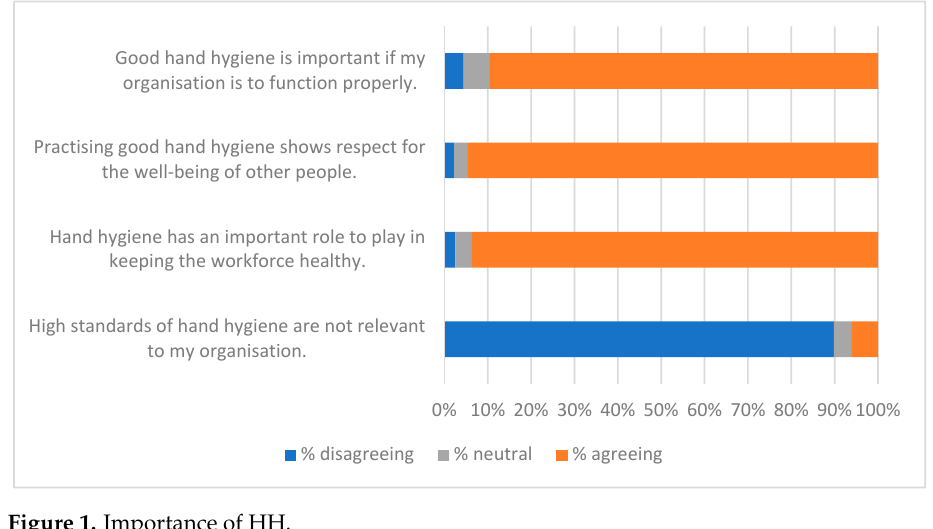
Figure 1. Importance of HH.